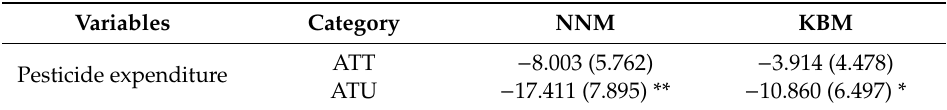
Figure A1. The quantity and proportion of pesticide use over time in China (1990–2016). Source: FAO STAT. Table A1. Impact of farm machine use on pesticide expenditure: propensity score matching (PSM)